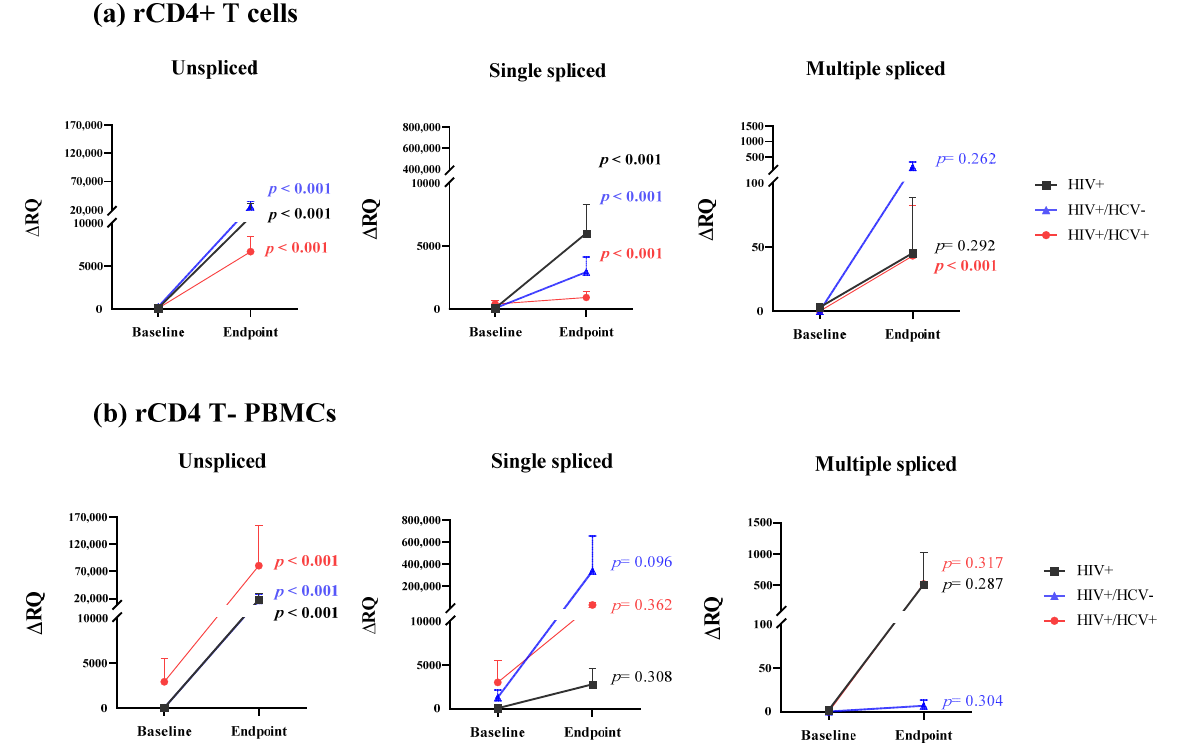
Figure 2. Evolution of HIV viral splicing in ( a ) rCD4+ T cells and ( b ) rCD4 T- PBMCs. Footnote: The study groups were: (1) HIV+: PLWH; (2) HIV+/HCV-: PLWH and HCV, who spontaneously cleared HCV infection; and (3) HIV+/HCV+: PLWH and HCV, who were never treated for HCV at baseline but achieved a sustained viral response with direct-acting antivirals at endpoint. Symbols with connecting lines represent reservoir-size arithmetic mean and standard error of the mean. Differences between baseline and endpoint for the different study groups were calculated using a mixed-model Gamma-distributed GLM. Statistical significance was defined as p < 0.05 (2-tailed). HIV, human immunodeficiency virus; HCV, hepatitis C virus; rCD4+ T cells, resting CD4+ T cells; rCD4 T- PBMCs, resting CD4 T cells-depleted PBMCs; baseline, time of the study when HIV+/HCV+ individuals had never been treated for hepatitis; endpoint, time of the study when HIV+/HCV+ subjects had cleared HCV by treatment with direct-acting antivirals.